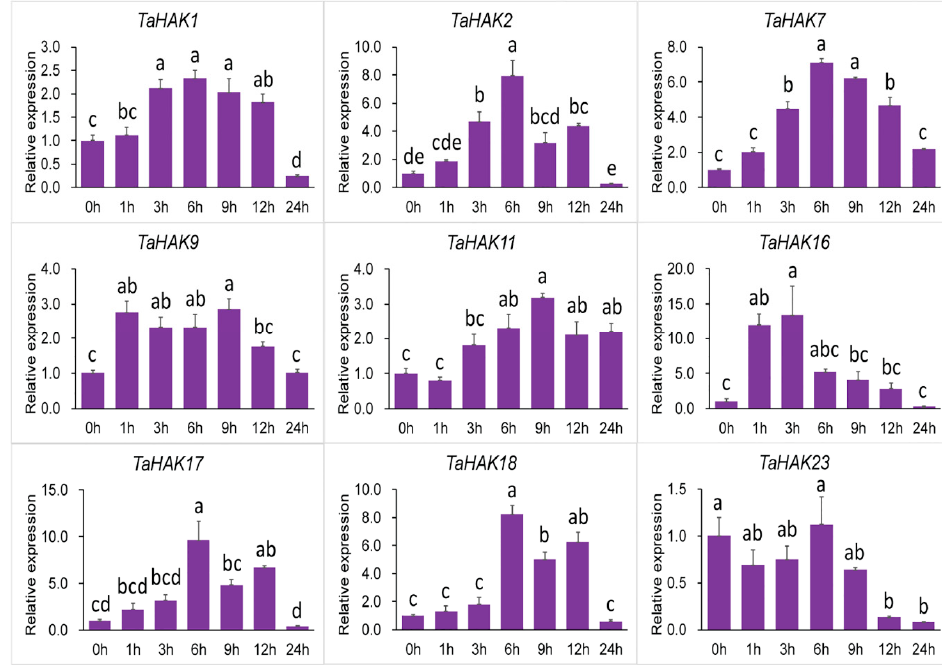
Figure 7. Expression of TaHAK genes in response to dehydration simulated by 20% PEG6000. Expression of TaHAK genes was determined by qRT-PCR using total RNA isolated from wheat roots at different time points (0, 1, 3, 6, 9, 12 and 24 h) of dehydration. One-way ANOVA with Duncan’s multiple range test was conducted using SPSS version 20.0. Different letters on top of error bars indicate significant differences at p = 0.05 level. Error bars indicate the SE of three replicates.